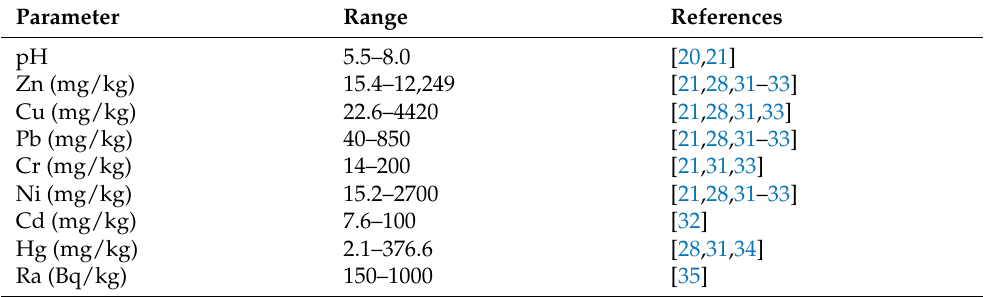
Table 1. pH, the concentration of heavy metals, and radioactivity of radionuclides in oily sludge. Parameter